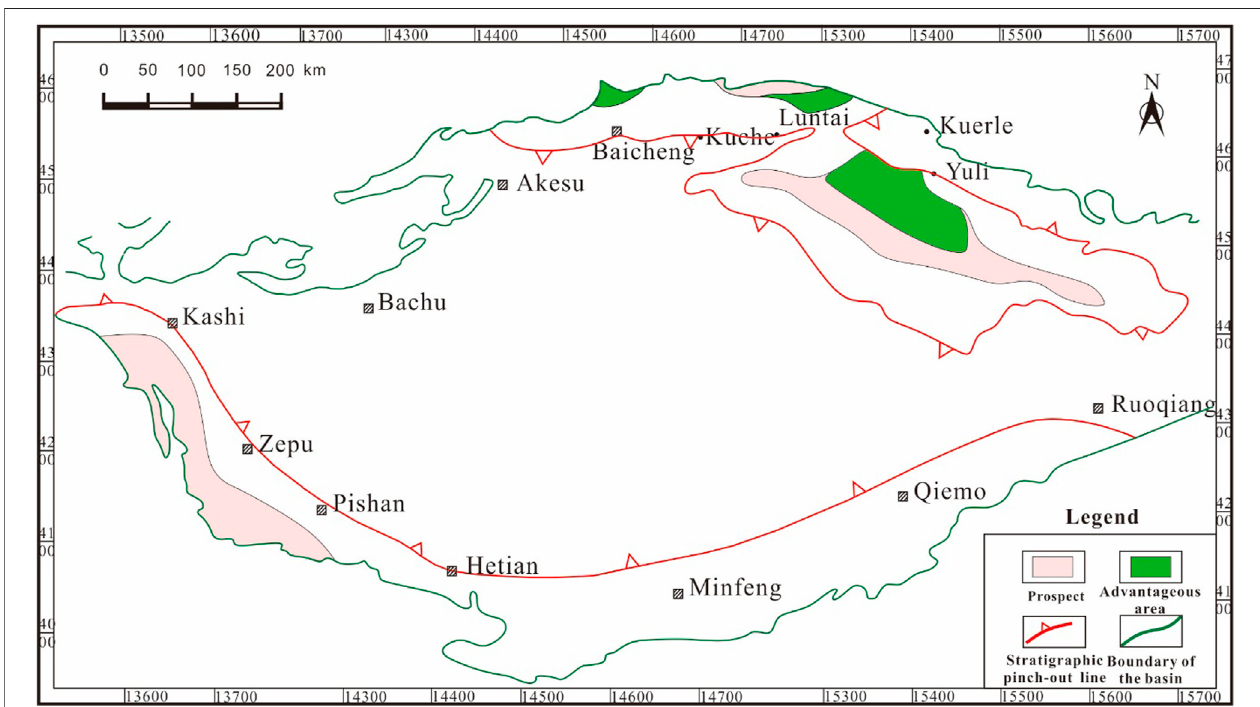
FIGURE 11 | Prediction plan of shale gas prospect and favorable area of Lower Jurassic in the Tarim